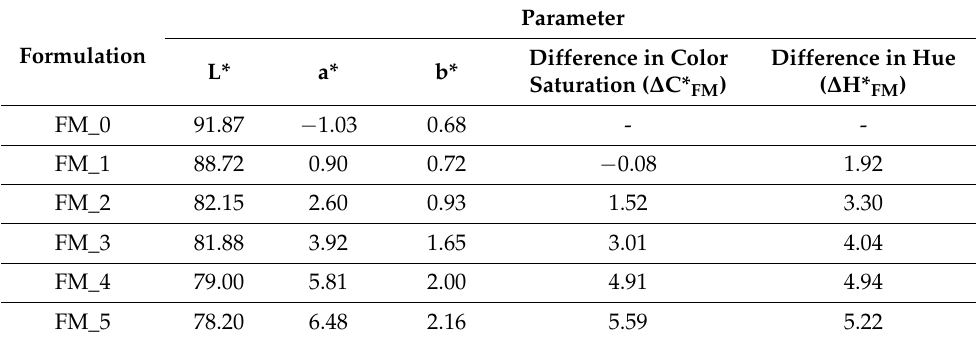
Table 3. Results of colorimetric measurements of cosmetic masks with varying concentrations of Lonicera Caerulea Fruit